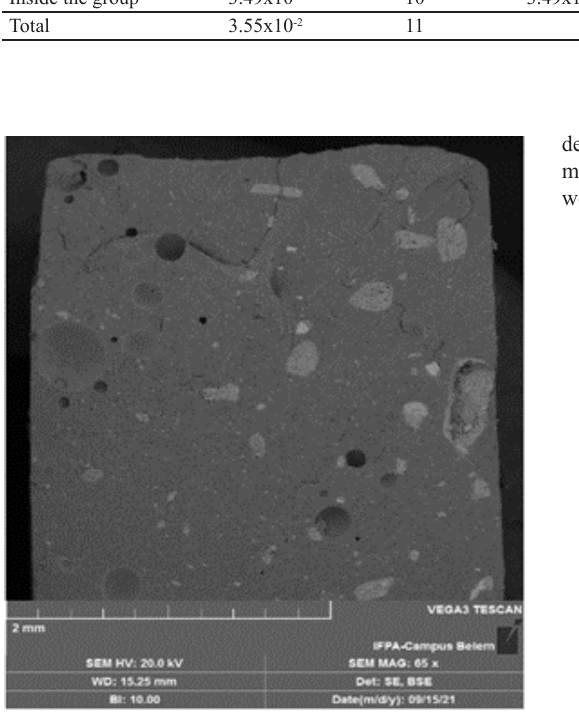
Figure 11. Cross-section of matrix composite